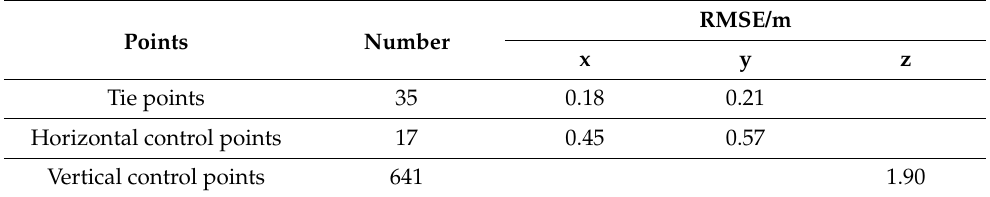
Table 1. The number of tie and control points with RMSE in DEM generation process of ZY-3 TLA. RMSE/m Points Number x y z Tie points 35 0.18 0.21 Horizontal control points 17 0.45 0.57 Vertical control points 641